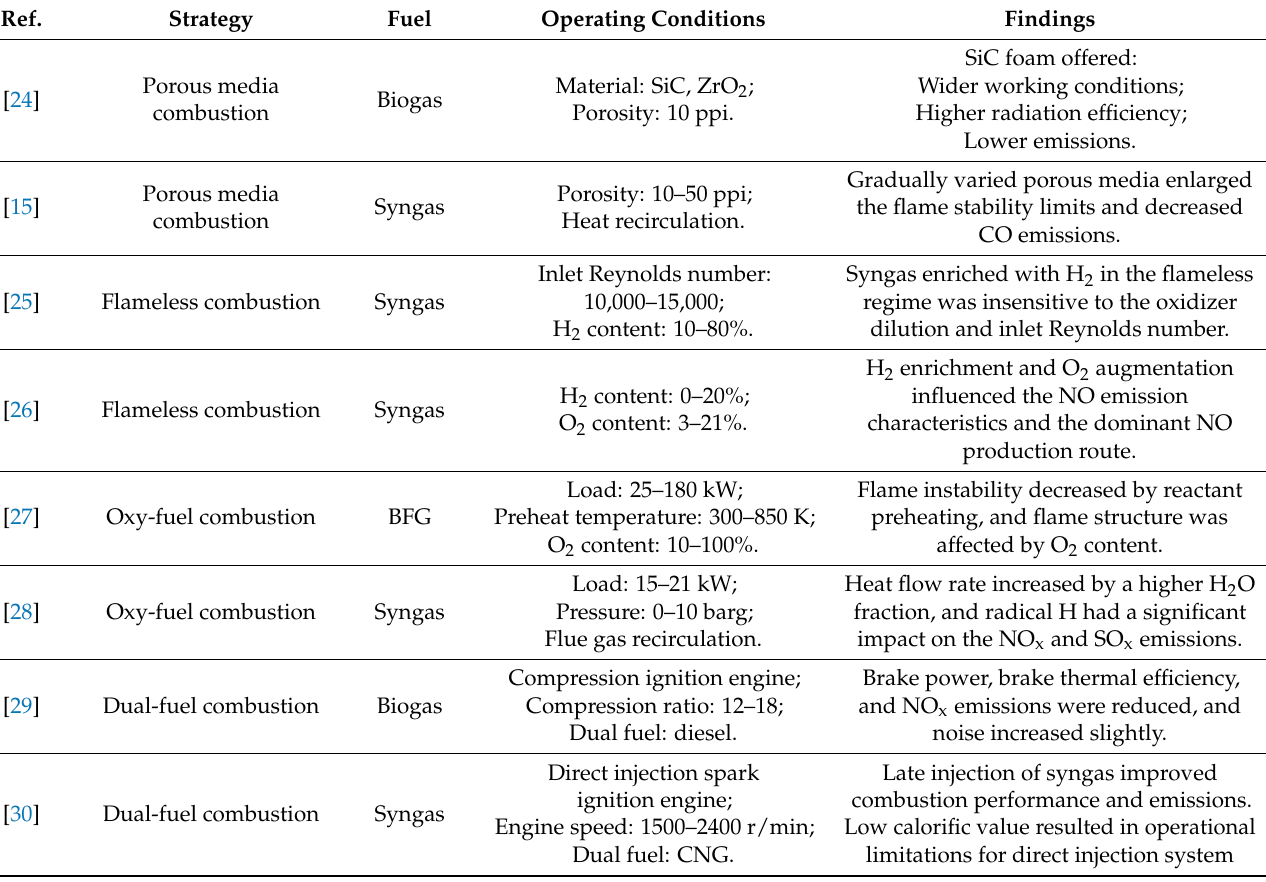
Table 3. Overview of LCIG combustion